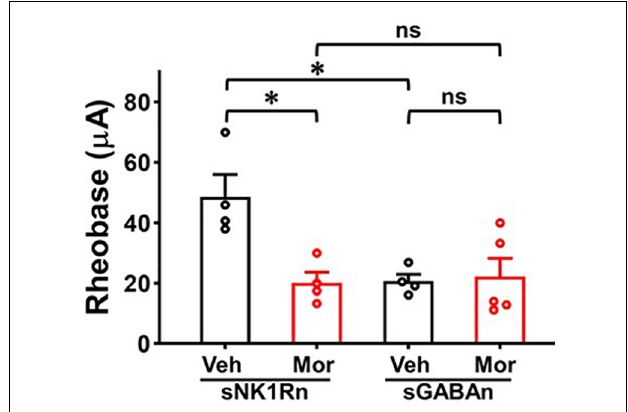
FIGURE 8 | Rheobase of sNK1Rn and sGABAn. Repeated morphine treatment decreased sNK1Rn rheobase (Effect size: –2.48, p = 0.022; Vehicle: N = 4, n = 21, Morphine: N = 4, n = 17) but had no significant effect on sGABAn rheobase (Effect size: 0.15, p = 0.812; Vehicle: N = 4, n = 45, Morphine: N = 5, n = 28) ∗ p < 0.05 vs. vehicle by Welch’s t test. ns: not significant. In vehicle groups, rheobase of sGABAn was significantly smaller in comparison to sNK1Rn (Effect size: –2.55, p = 0.026). ∗ p < 0.05 vs. vehicle of sNK1Rn by ordinary one-way ANOVA with Tukey’s multiple comparisons test.